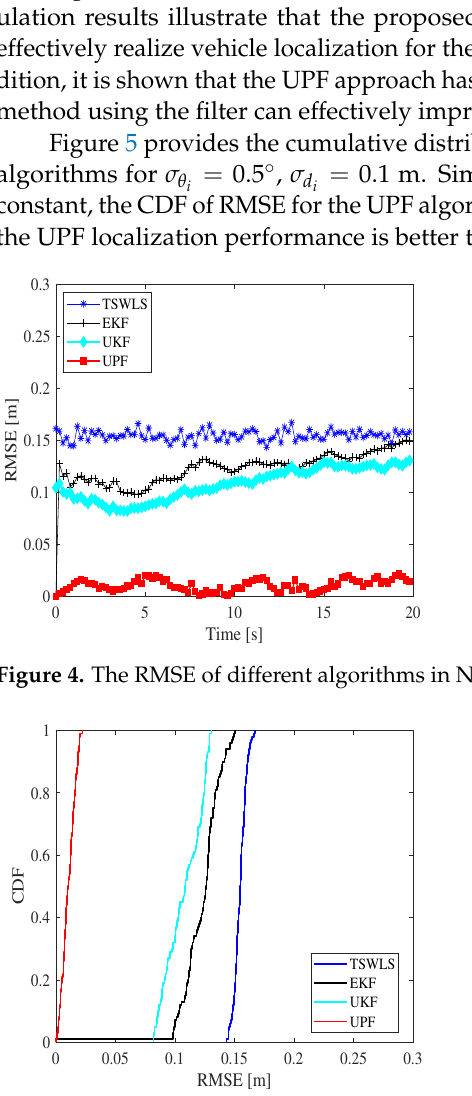
= 0.5 ◦ , σ = 0.1 d i i